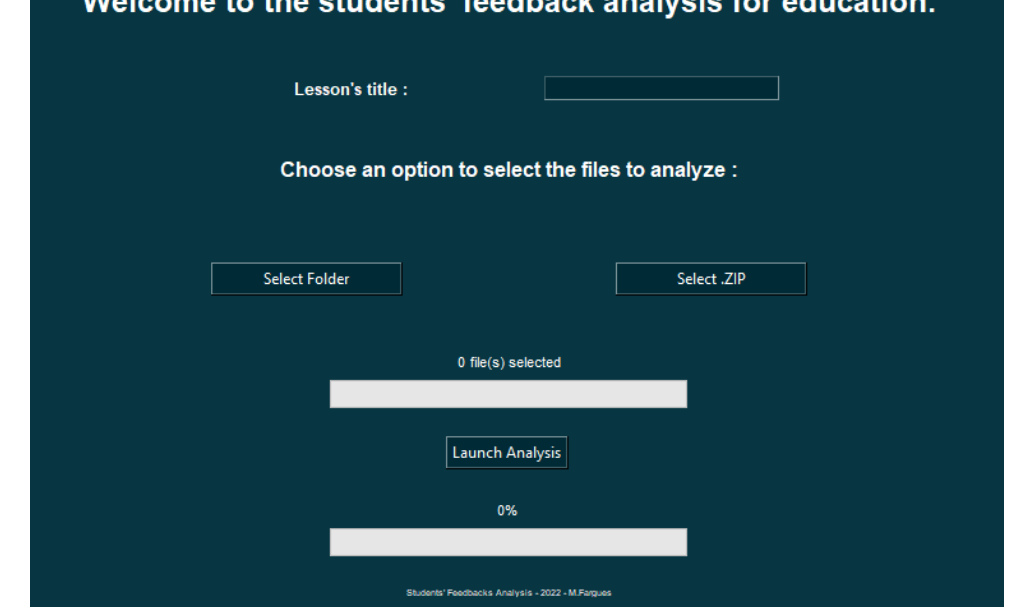
Figure 2. Main screen of the user